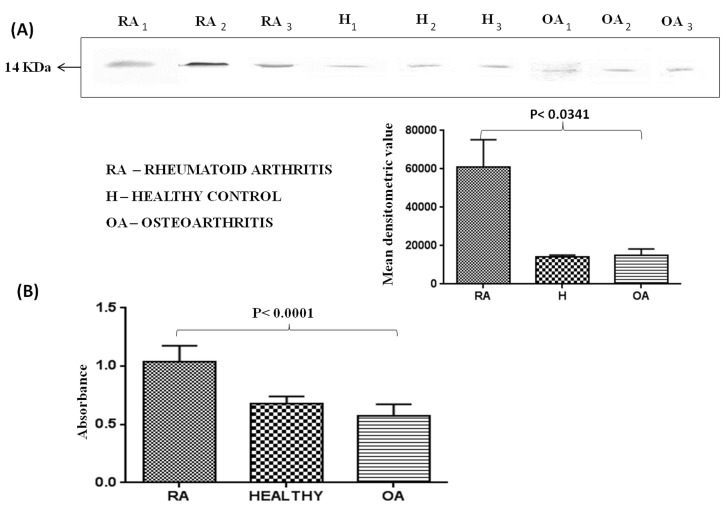
Quantitation of autoantibodies against TTR in plasma of RA, OA patients and healthy controls.(A) TTR was immunoprecipitated using anti-TTR antibody and separated on SDS-PAGE and Western blotting was performed. Autoantibodies against TTR in RA (n = 30) were approximately 5 fold higher as compared to healthy control (n = 30) and OA (n = 34) patients. Each bar represents the mean ± SD of values obtained from densitometeric analysis of bands. (B) Expression of autoantibodies against TTR in RA was further confirmed by ELISA and analysis showed 1.6 and 2 fold higher levels of autoantibodies in RA as compared to healthy control and OA respectively.